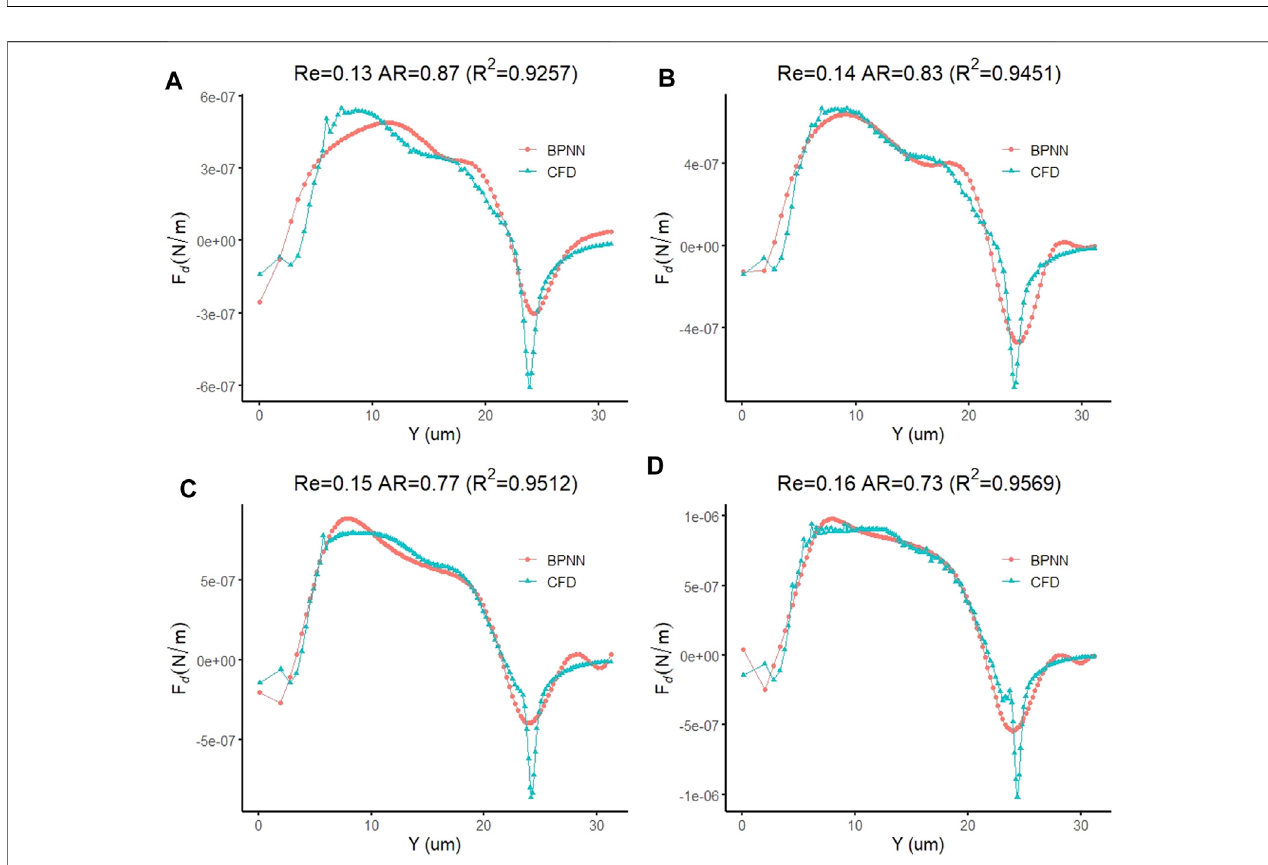
FIGURE 15 | Prediction accuracy of the leukocyte transmigration prediction model for the prediction of fl uid lift forces on cells (A) Re = 0.13, AR = 0.87; (B) Re = 0.14, AR = 0.83; (C) Re = 0.15, AR = 0.77; (D) Re = 0.16, AR = 0.73.